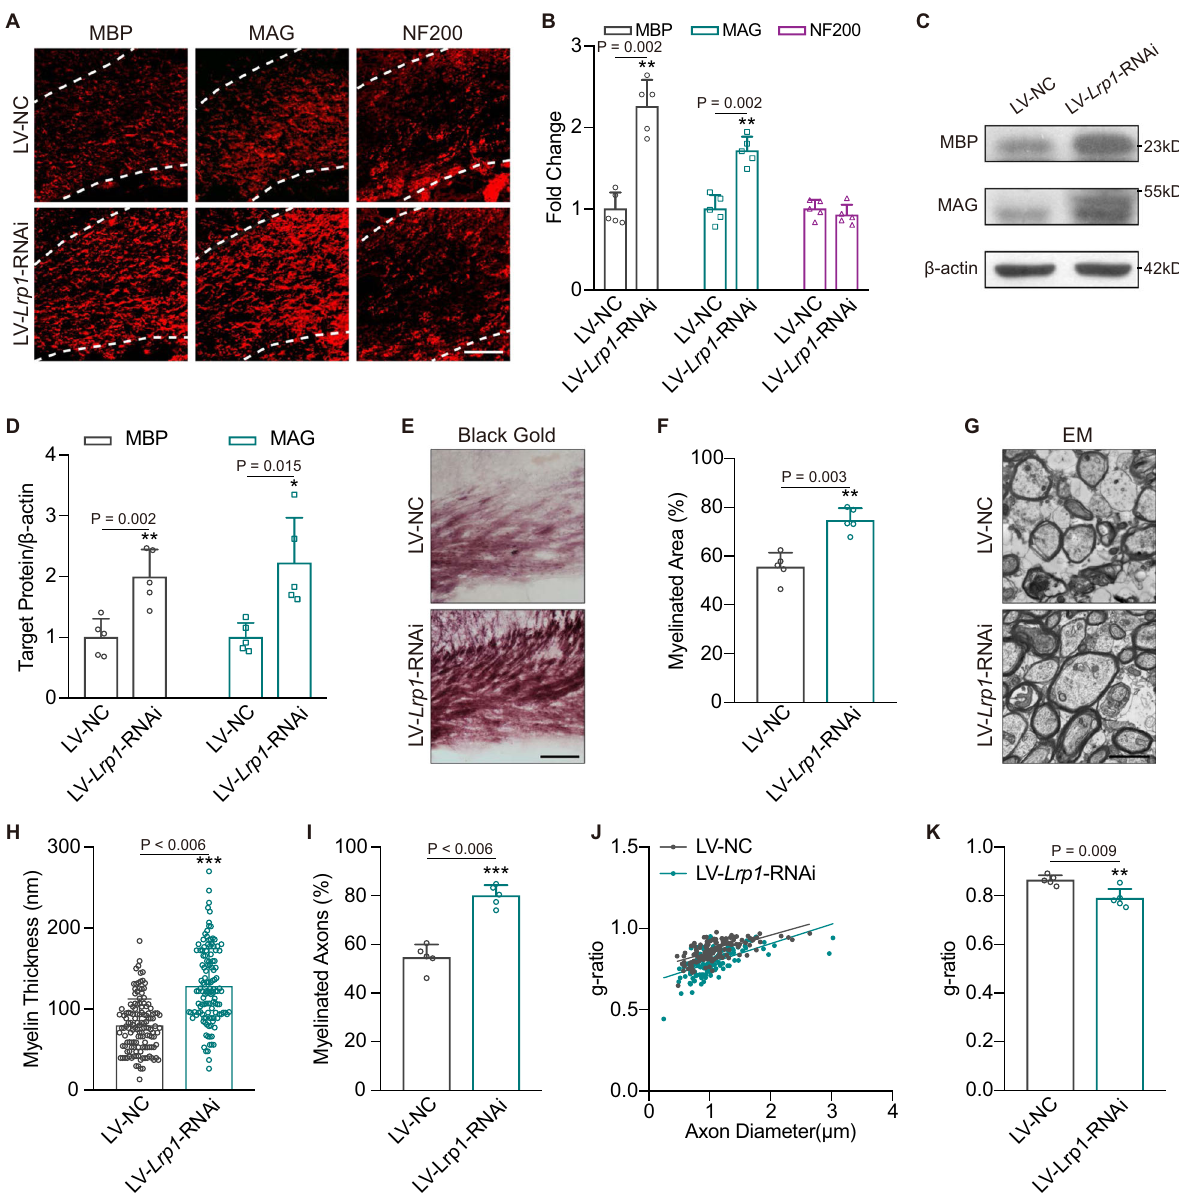
Fig. 10 Lrp1 knockdown reverses LCN2-induced demyelination following cortical infarction. A , B Representative MBP, MAG and NF200 staining and statistical analyses of the CC in dMCAO mice injected with LC-NC or LV- Lrp1 -RNAi ( n = 5 mice; mean ± S.D.; ** P < 0.01 vs. LC-NC; paired t -test). Scale bar, 50 μ m. C , D Immunoblotting analyses showing the changes of MBP and MAG expressions after transfection ( n = 5 mice; mean ± S.D.; * P < 0.05, ** P < 0.01 vs. LC-NC; paired t -test). Protein samples derived from the same experiment and gels/blots were processed in parallel. E , F Representative black gold staining and quanti fi cation of dMCAO mice receiving lentivirus ( n = 5 mice; mean ± S.D.; ** P < 0.01 vs. LC-NC; paired t -test). Scale bar, 50 μ m. G – K Representative EM images and quanti fi cations from two groups ( n = 5 mice; mean ± S.D.; ** P < 0.01, *** P < 0.001 vs. LC-NC; paired t -test). Scale bar, 2 μ m. Source data are provided as a Source Data fi le. and 1% osmium tetroxide. After dehydration and insertion, samples were cut into collected and proteins were eluted followed by immunoblotting analysis. For 50 – 60 nm slices and scanned by an H7500 Transmission Electron Microscope immunoblotting, proteins (25 μ g for cells, 50 μ g for tissues) were separated by (Hitachi, Japan). The myelin thickness, the percentage of myelinated axons and sodium dodecyl sulfate-polyacrylamide gel electrophoresis (SDS-PAGE) electro- g-ratio (inner axonal diameter/outer fi ber diameter) were calculated using ImageJ phoresis and then transferred to polyvinylidene di fl uoride (PVDF) membranes software. (Millipore, USA). After blocked with 5% skim milk at room temperature for 60min, the membranes were incubated with primary antibodies overnight at 4°C. Then HRP-conjugated secondary antibodies were used to incubate with the membranes for 60min at room temperature. Speci fi c protein signals were detected by enhanced chemiluminescence (ECL) reagents (Millipore, USA) and analyzed by ImageJ software. Uncropped gels are shown in the Source Data fi le.